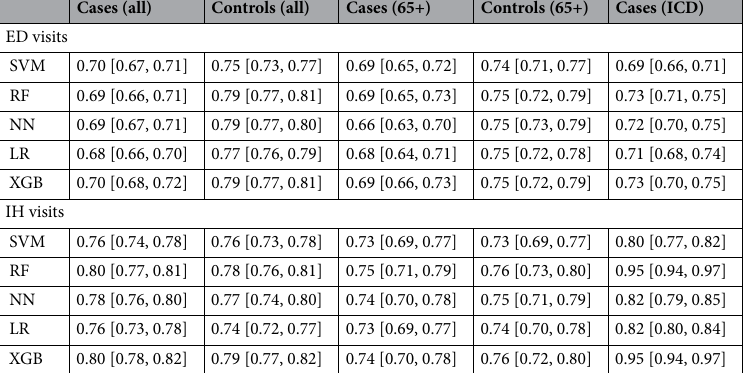
Cases (all) Controls (all) Cases (65+) Controls (65+) Cases